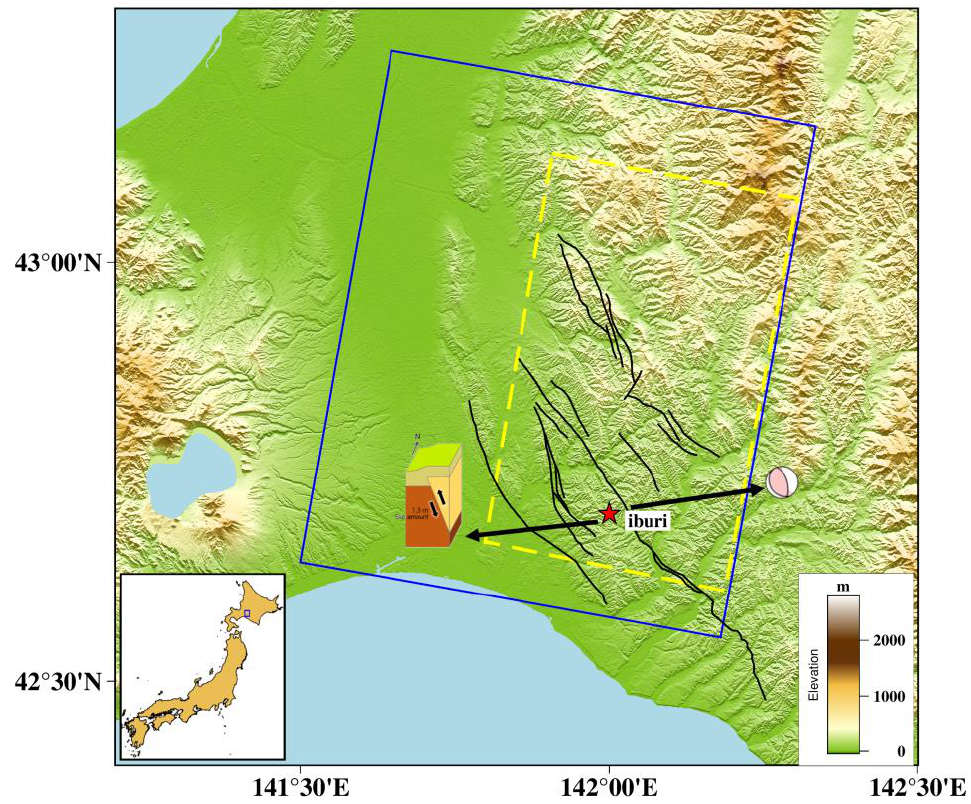
Figure 1. Geographic location of the study area. The blue line represents the coverage of ALOS-2 PALSAR-2 data, and the yellow line represents the scope of this study. The faults, crustal velocity, epicenter, and slip model are from the Geospatial Information Authority of Japan (GSI), while the focal mechanism is from the United States Geological Survey (USGS).